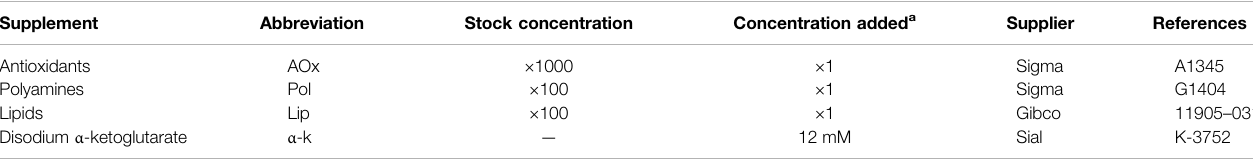
TABLE 1 | List of culture medium